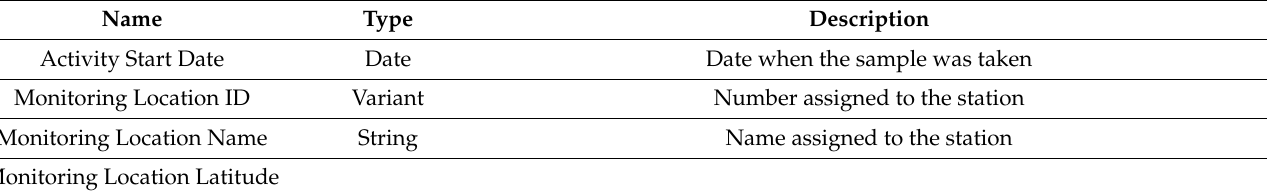
Table 1. WQDV data